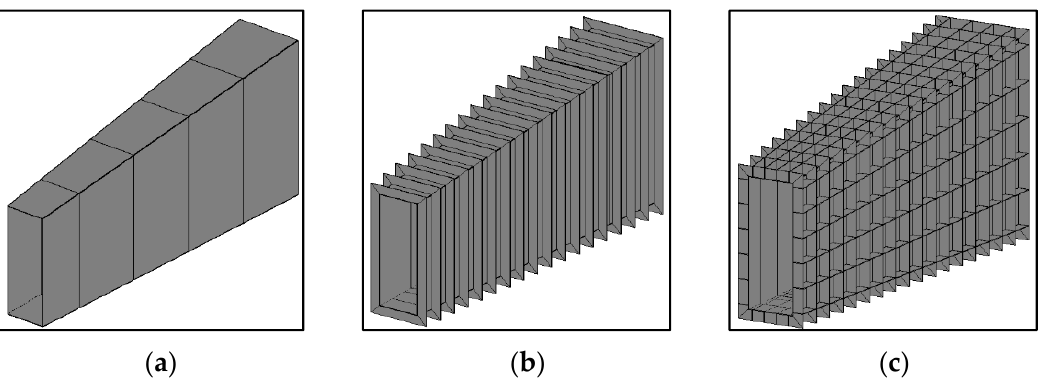
Figure 9. ( a ) Inner steel sheet; ( b ) Transversal stiffening members; ( c ) Longitudinal stiffening members. The dimensions of the double wall structure change along the 50 m length of the Decay Volume. The initial cross-section of the Decay Volume is about 3 m × 5.5 m (external steel sheet). The final cross-section is about 6 m × 12 m (external steel sheet). The design of the structure leads to a total of 1848 compartments for the liquid scintillator detector. Studies with a prototype compartment in the test beam have verified that the dimensions given by the vessel skeleton of about 800 mm × 1200 mm are acceptable. The total weight of the structure and plates forming the Decay Volume is about 550 tonnes.